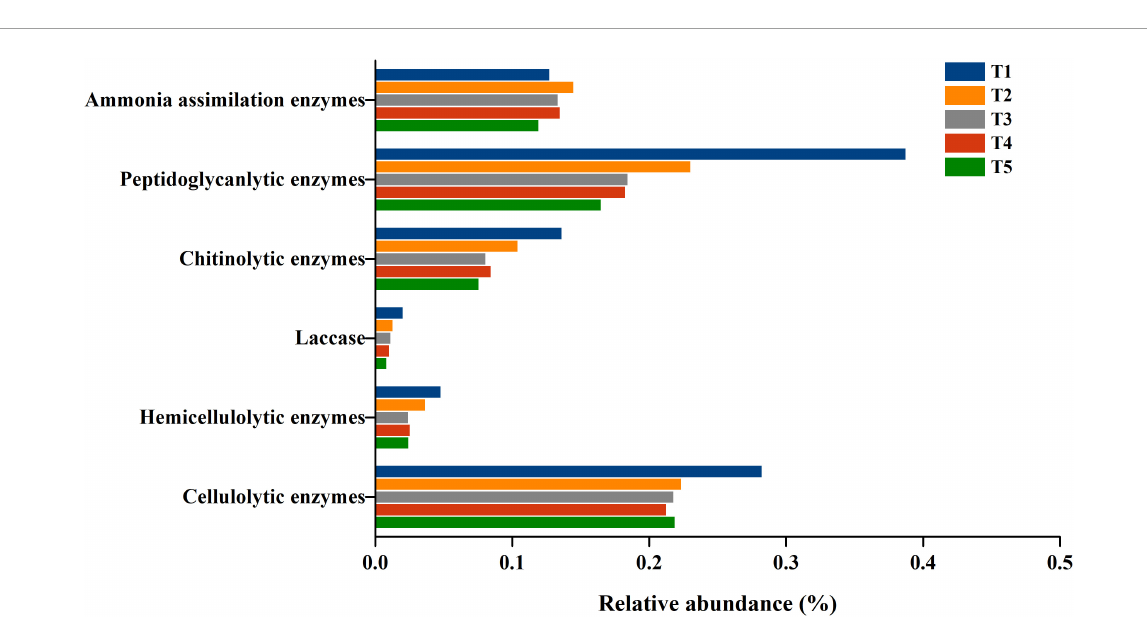
FIGURE7 The relative abundance of COG genes with cell wall degradation functions in composting substrate at the different growth stages of oyster mushroom. T1, T2, T3, T4, and T5 indicate the day on which composting was completed (day 0: before spawning), mycelial colonization (day 3), mid-incubation (day 10), end-incubation (day 20: before primordia formation), and first oyster mushroom fructification (day 30: fruiting body development),